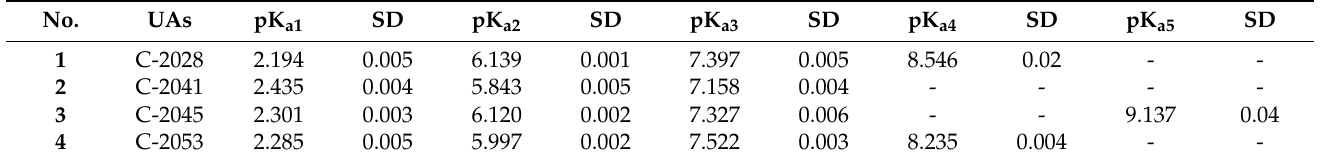
Table 1. pK a and standard deviation values, calculated using leave-one-out cross validation.